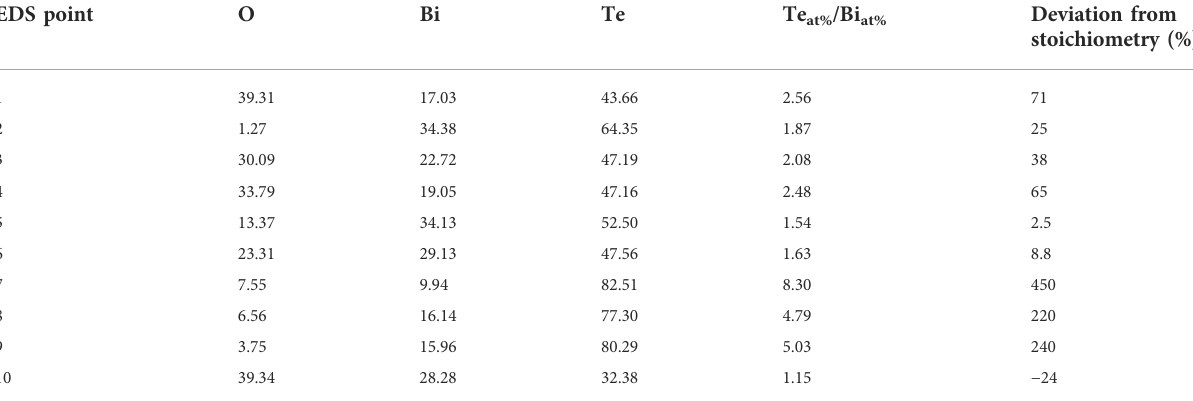
TABLE 2 Variation of atomic percentage of oxygen, bismuth, and tellurium in the corresponding EDS data for points shown in Figure 11. EDS point O Bi Te Te at% /Bi at% Deviation from